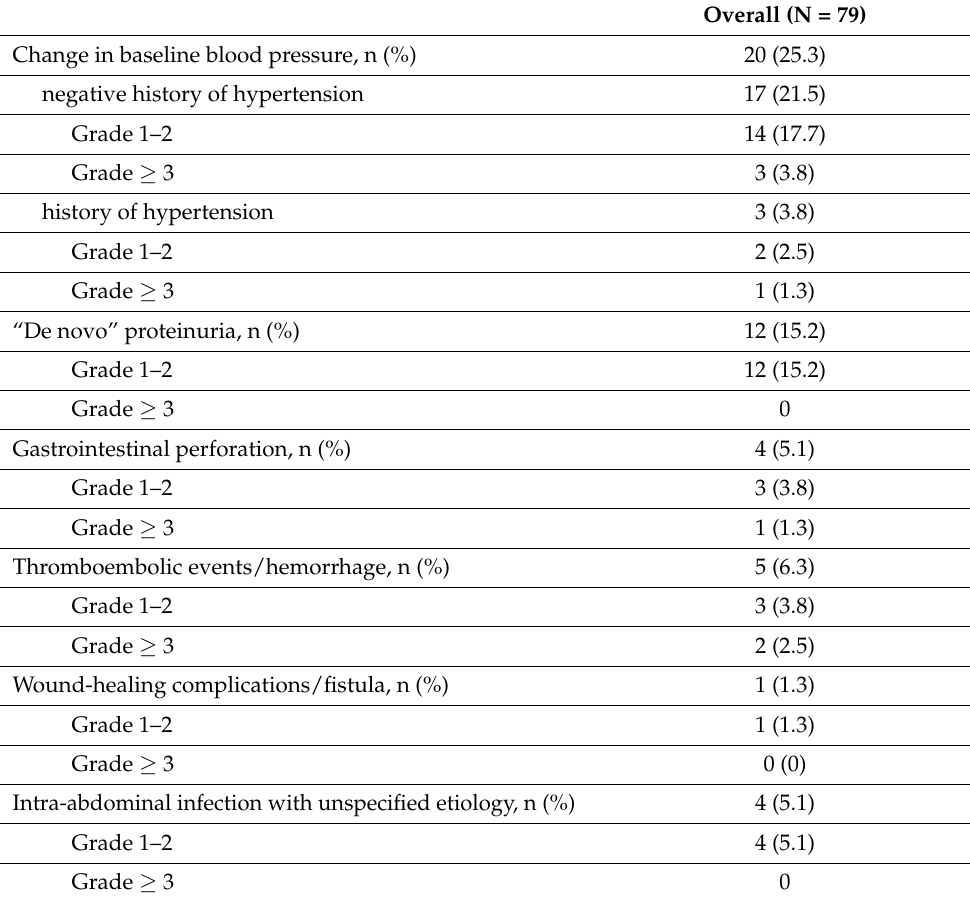
Table 3. Assessing the adverse events after exposing to